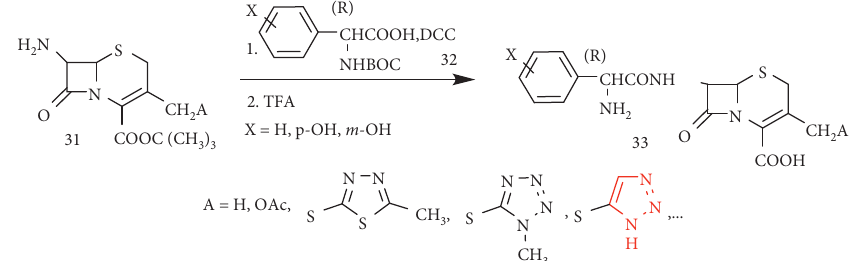
Scheme 13: Path of CAI synthesis.